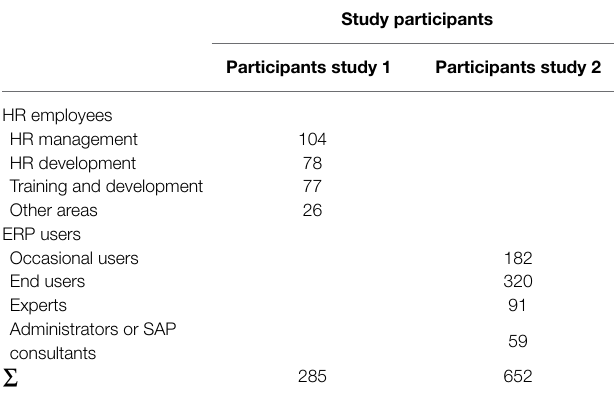
TABLE 2 | Overview participants study 1 and study